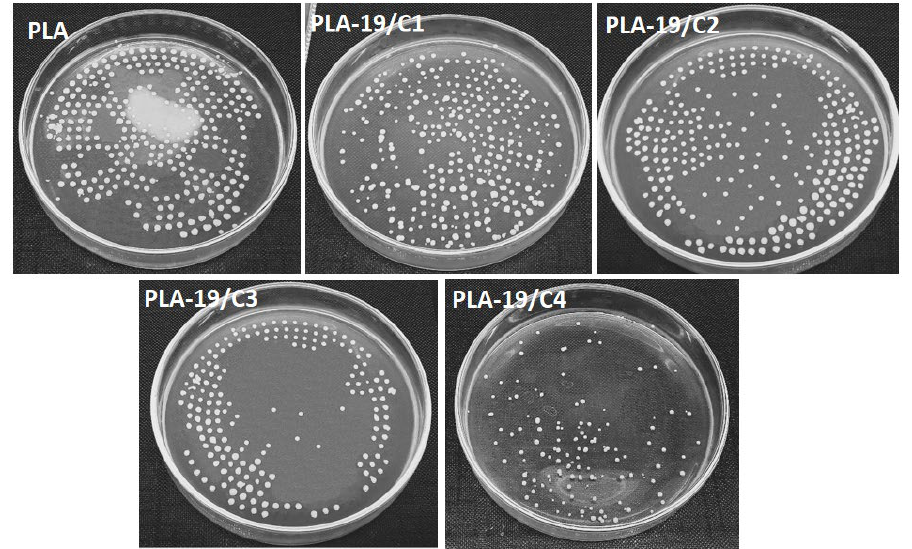
Figure 8. Quantitative measurement of antimicrobial activities of 19% PLA nanofibers with different CND concentrations against E. coli bacteria.